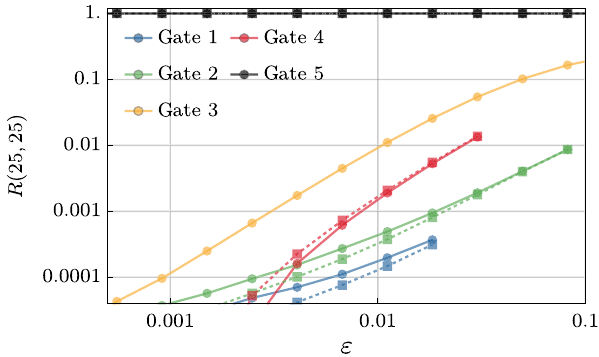
; x − Þ [cf. Eq. (76)] for x FIG. 4. Relative error R ð x ¼ x − as a þ þ function of ε , with maximal density of defects δ ¼ 1 . Full and dashed lines, respectively, correspond to integer and half-odd- integer end points ( x ∈ Z ; Z þ 1 ), while different colors corre- 2 spond to different gates (specified in Table I). Note that the gate corresponding to the black line does not fulfill the condition (70).